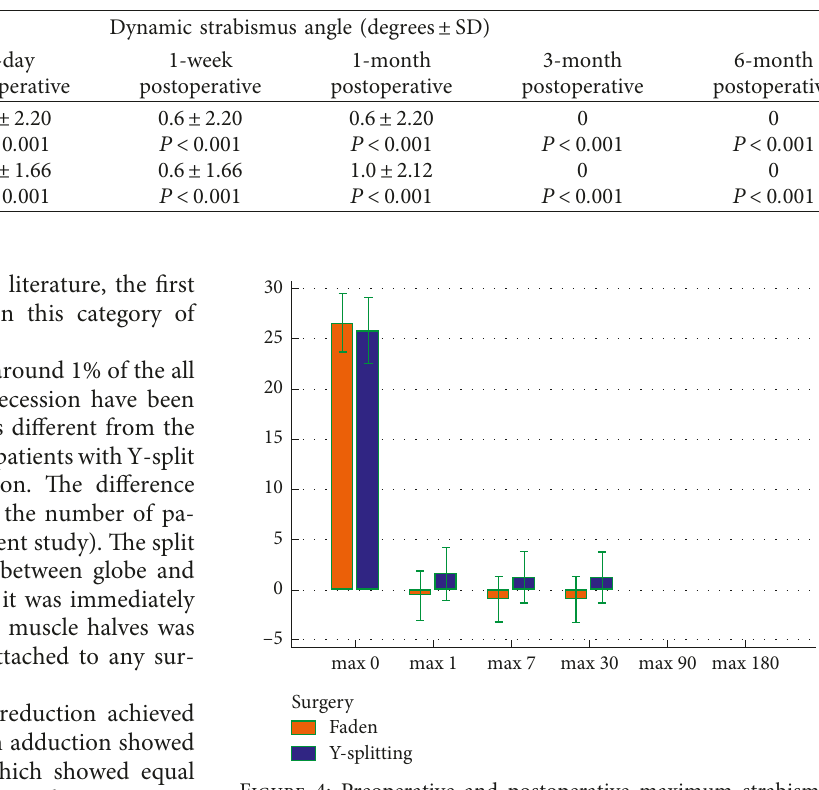
Table 3: The average values of the dynamic strabismus angles preoperatively, one day; one week; one, three, and six months postoperatively.